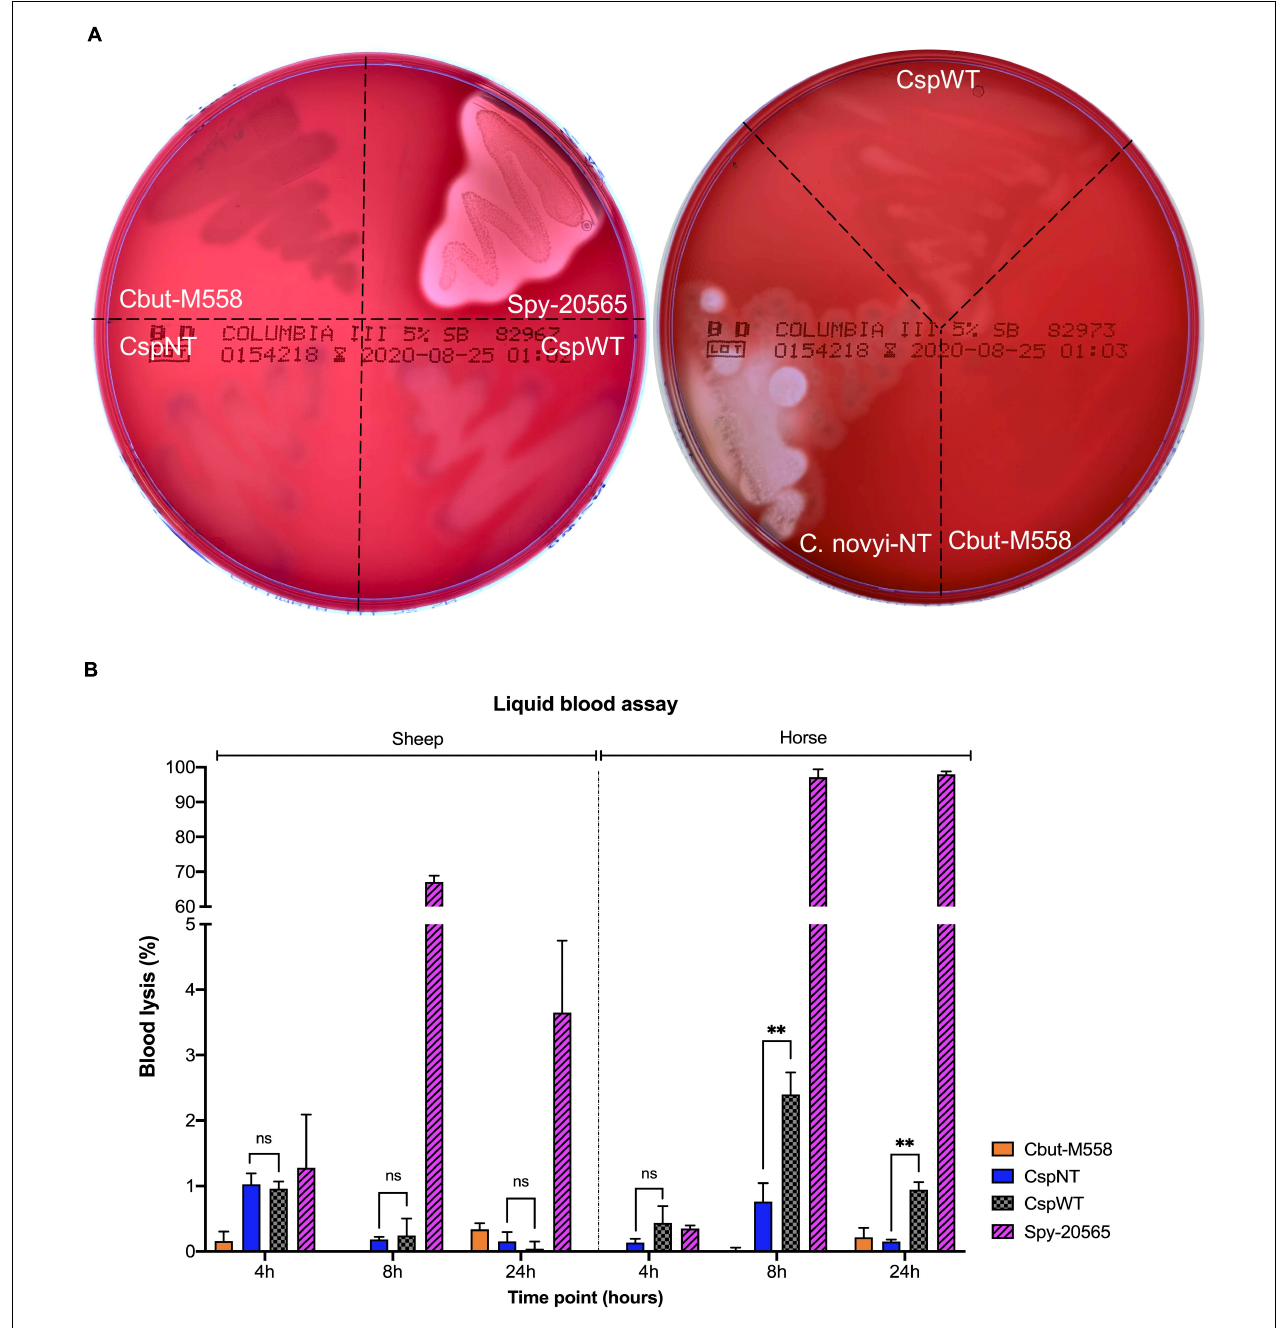
FIGURE 2 | Analysis of haemolytic activity. (A) Five strains were streaked on two Columbia Blood Agar plates (5% sheep blood BD Bioscience) and incubated under anaerobic conditions for 48 h. The strains were: Cbut-M558: C. butyricum MIYAIRI 585 (negative control), Csp-20565: S. pyogenes DSM 20565 (positive control), CspNT: C. sporogenes -NT, CspWT: C. sporogenes -WT and C. novyi -NT. (B) Quantitative analysis of haemolysis in two liquid blood assays (using sheep and horse blood). Samples from liquid cultures were assayed at 4, 8, and 24 h. Haemolysis is presented as a percentage of total lysis (blood incubated with ultrapure water). Assayed strains: Cbut-M558: C. butyricum MIYAIRI 588; CspNT: C. sporogenes -NT; CspWT: C. sporogenes -WT; Spy-20565: S. pyogenes DSM 20565.